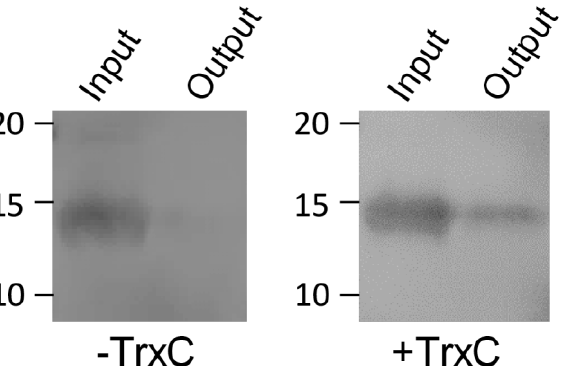
Figure 1. His-tag–based pull-down assay of the SqrR–TrxC interaction. SqrR-FLAG was mixed with Ni-resin in the absence ( − TrxC) and presence (+TrxC) of His-tagged TrxC. Input and output were analyzed by Western blotting using an anti-FLAG antibody to detect SqrR-FLAG. The numbers to the left of the images indicate molecular weight based on size markers (kDa).